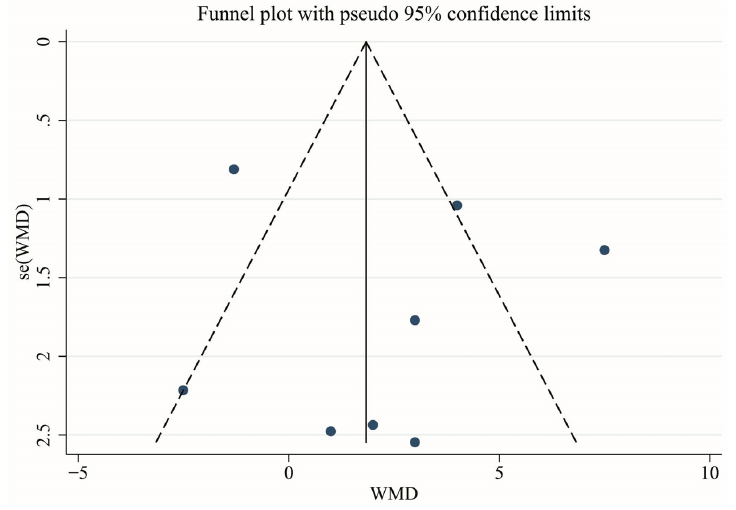
Figure 11. Funnel plot of the effect of omega-PUFAs on LVEF. Abbreviations: LVEF, left ventricular ejection fraction; PUFAs, polyunsaturated fatty acids